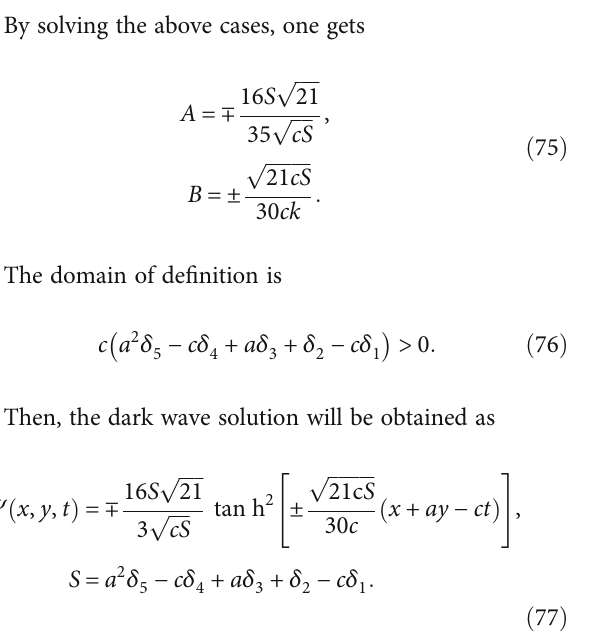
Figure 10: Plot evolution of cross-kink waves (41) utilizing values a = 2, δ = 1 : 3, δ = 2, Ψ = 1, t = 10 and (a) 3D plot, (b) density plot, and (c) contour , δ 3 4 5 0